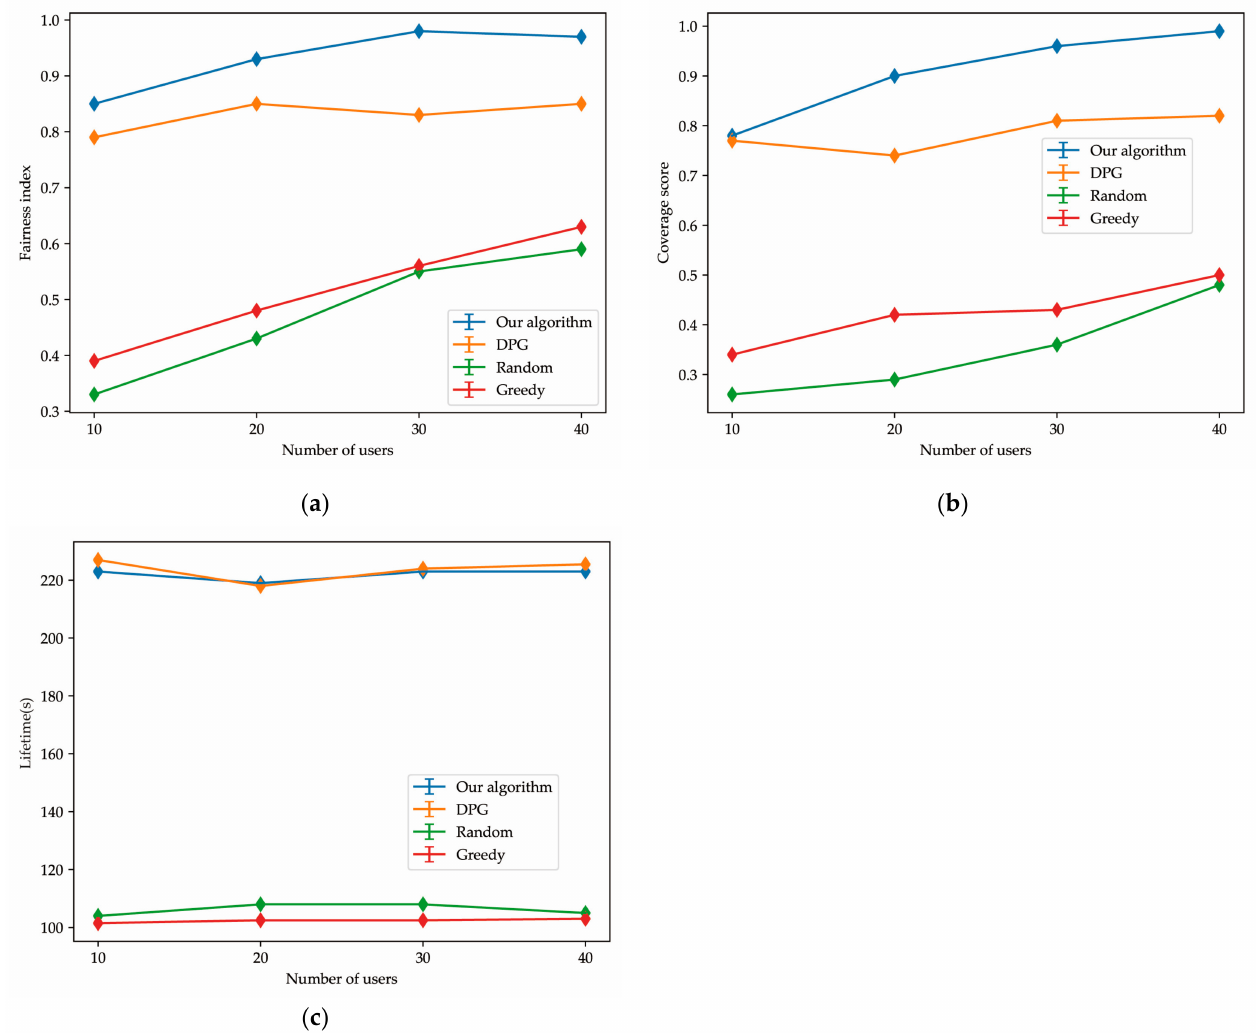
Figure 8. ( a ) Fairness index trend changing with the number of users changes; ( b ) coverage score trend changing with the number of users changes; ( c ) lifetime trend changing with the number of users